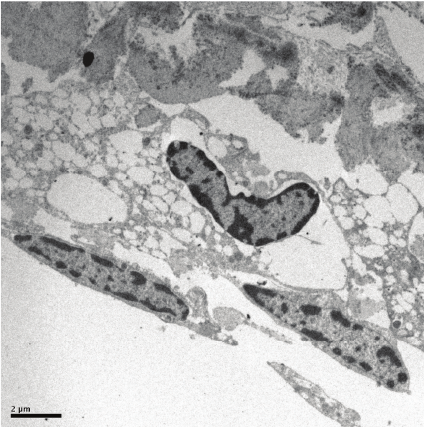
Figure 1: TEM of untreated TM showing intact trabecular endothe- lial cells and intertrabecular spaces.